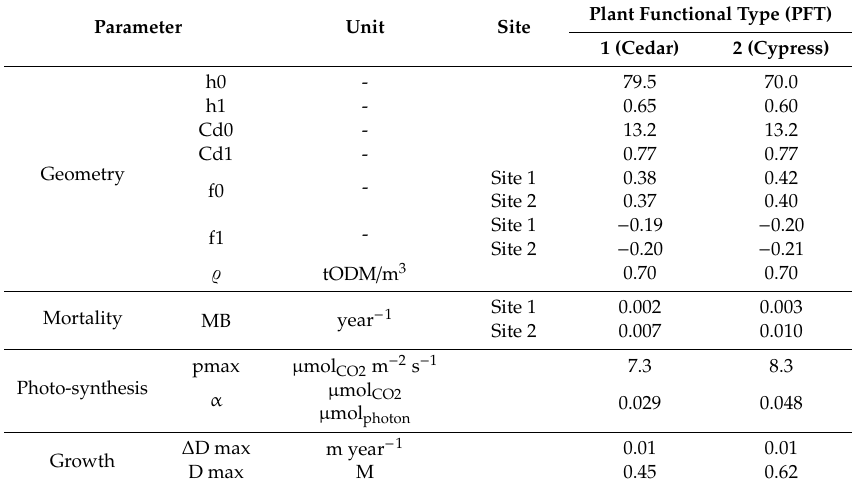
Table A1. PFT-specific